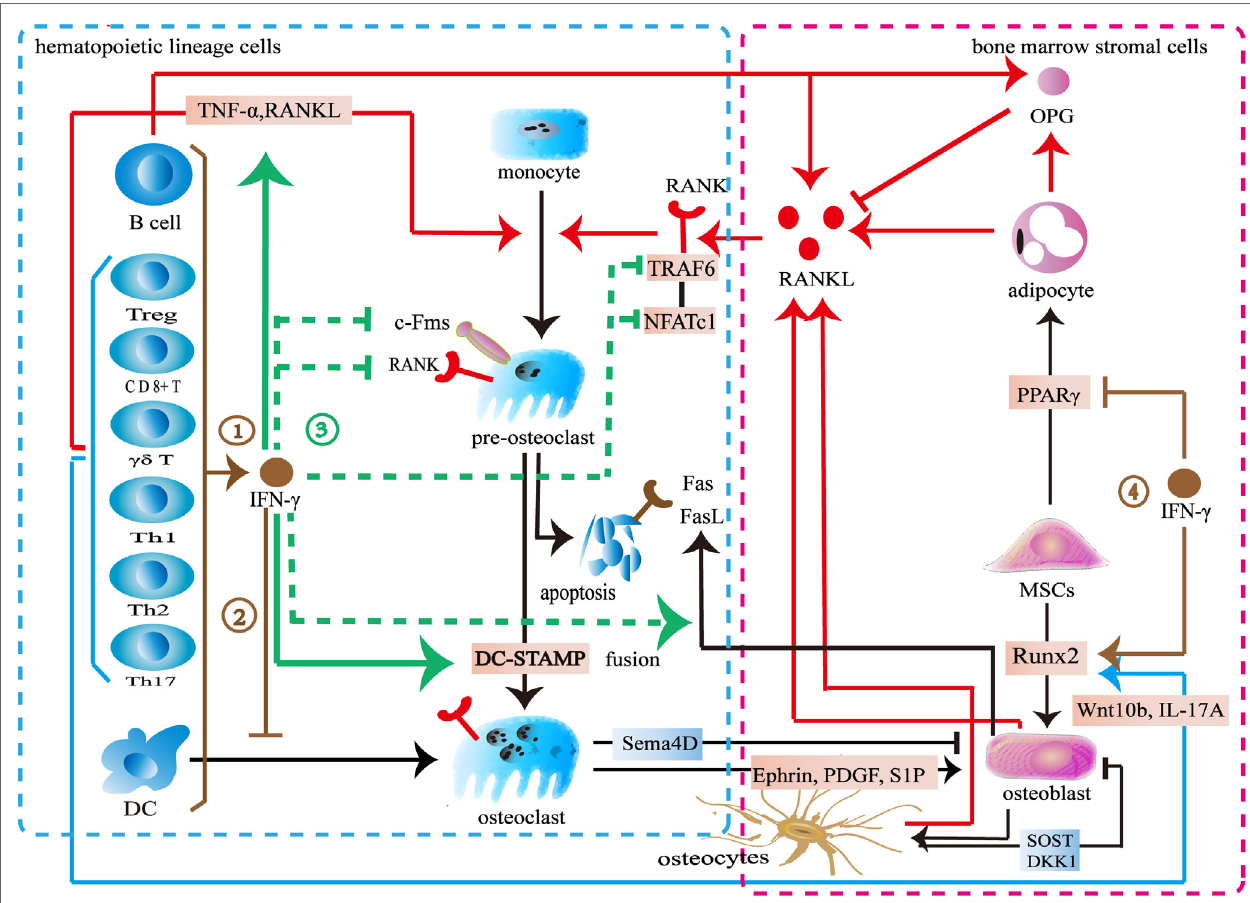
FiGURe 3 | Effect of interferon-gamma (IFN- γ ) in osteoimmunology. ① IFN- γ is produced by multiple immune cells including CD4 + T cells, CD8 + T cells, Treg cells, γδ T cells, B cells, and dendritic cells. ➁ IFN- γ inhibits the differentiation of DCs into osteoclasts. ➂ IFN- γ reduces the expression of c-Fms on the surface of osteoclast precursors to inhibit its proliferation and differentiation. IFN- γ decreases the number of RANK + osteoclast precursors to influence subsequent RANKL-dependent osteoclastogenesis. IFN- γ also increases the degradation of tumor necrosis factor receptor-associated factors 6 (TRAF6) or downregulates NFATc1 in the downstream of RANK–RANKL pathway to inhibit osteoclastogenesis in the early stage of osteoclast differentiation. IFN- γ enhances the apoptosis of osteoclast precursors through FasL. IFN- γ reduces osteoclast formation by directly inhibiting RANK–RANKL pathway, while stimulates the secretion of TNF- α and RANKL by T cells to promote osteoclast formation. IFN- γ promotes the fusion of mononucleate osteoclasts into functional osteoclasts through DC-STAMP. ➃ IFN- γ upregulates the osteogenic transcription factor Runx2 and downregulates the adipogenic transcription factor PPAR γ